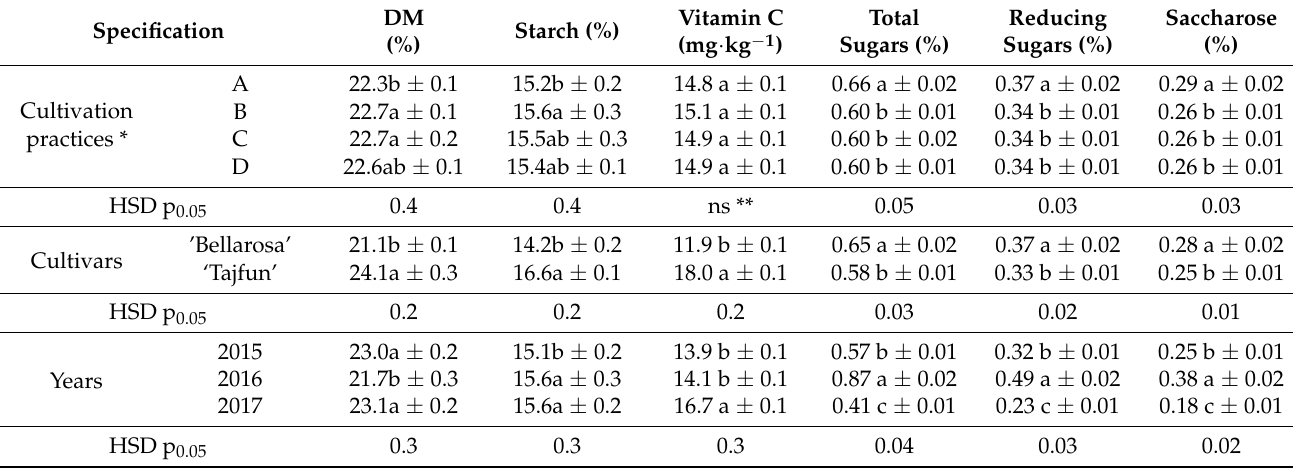
Table 9. Influence of cultivation practices, varieties, and years on the content of DM, starch, total sugars, reducing sugars, and